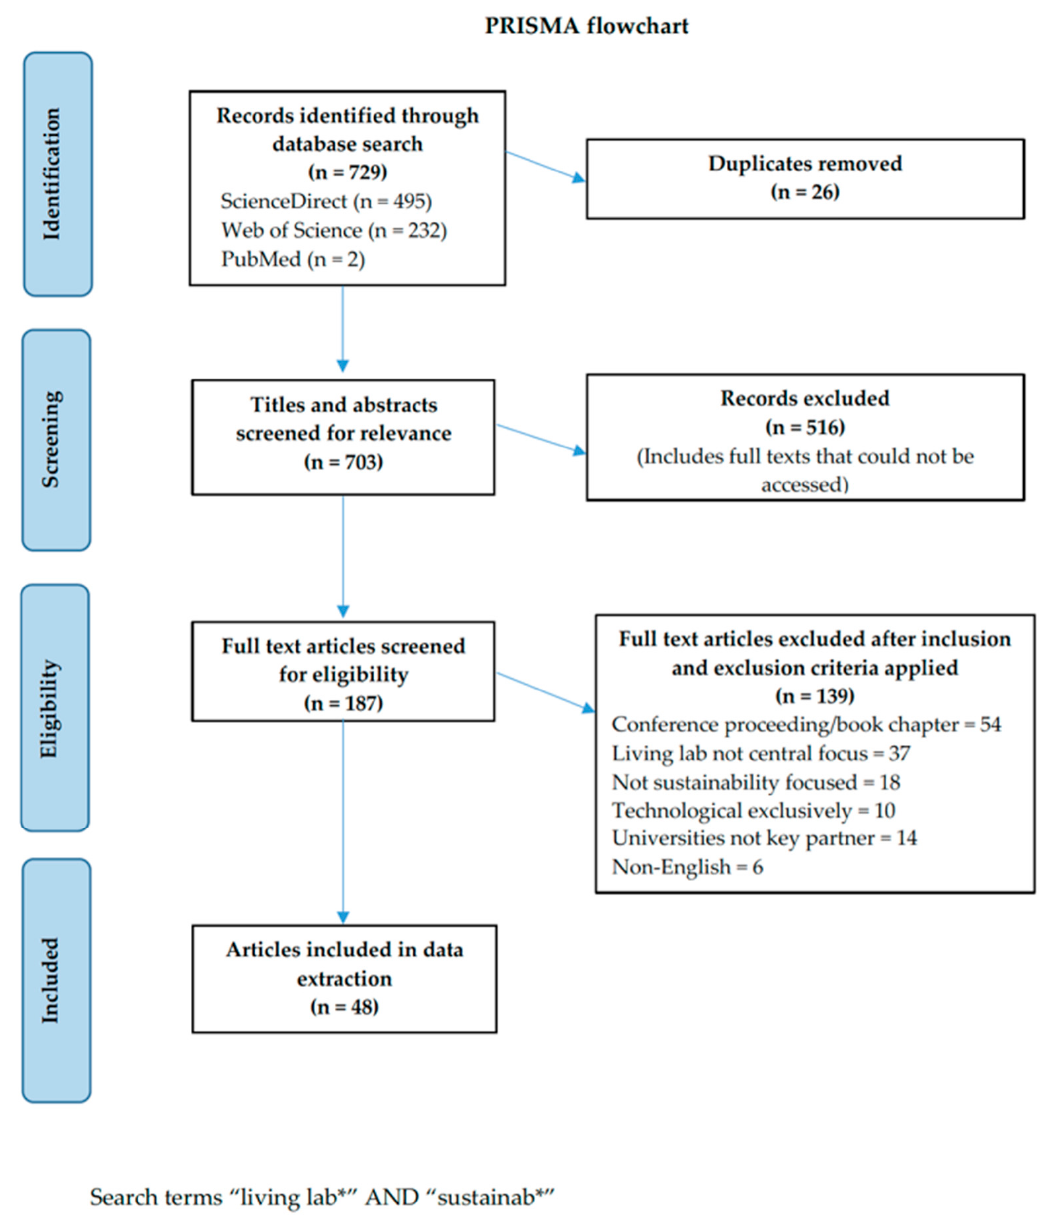
Figure 2. PRISMA Diagram. (* used in search for variations of word endings)